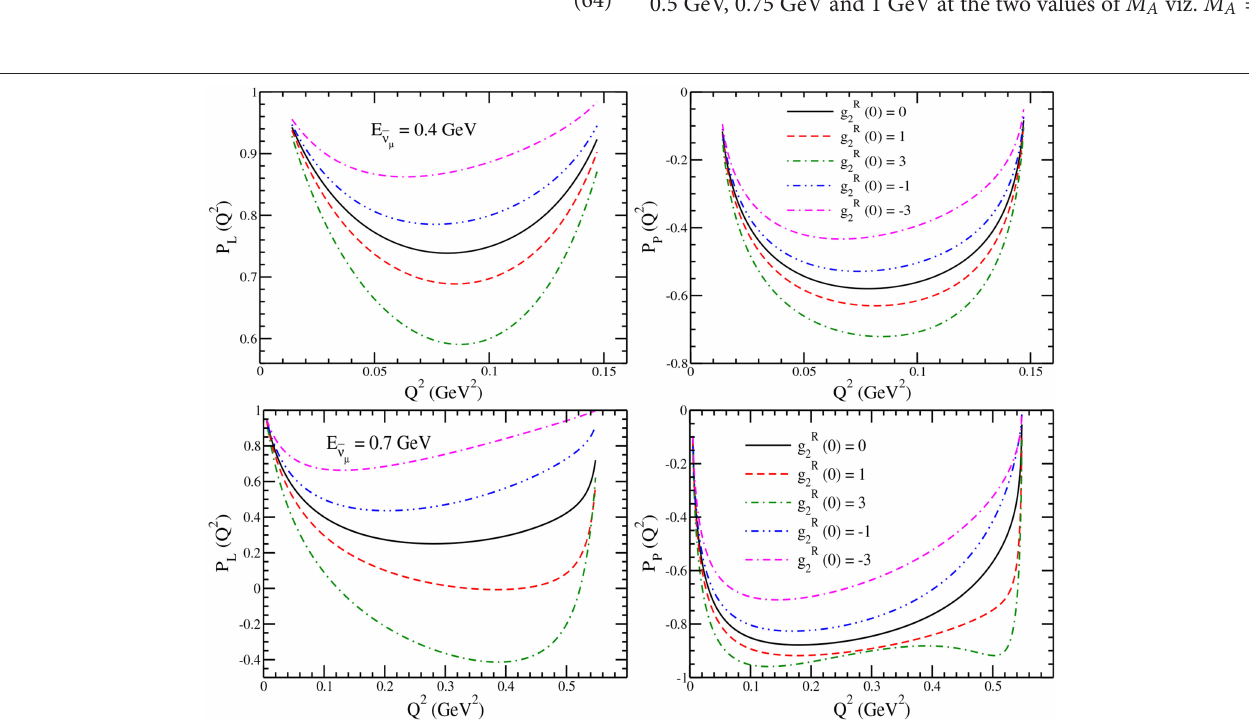
p ν µ µ + 3 at E ν µ = 0.4 GeV (upper) and 0.7 GeV (lower) with g R 2 (0) = 0 (solid line), 1 (dashed ¯ + → + ¯ 3 (double-dash-dotted line). −